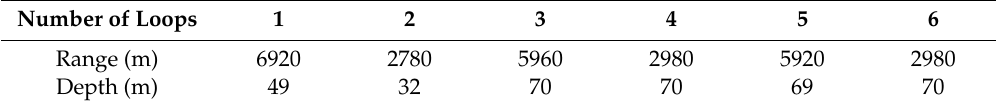
Table 1. The estimated positions using the RAMP method with a spatial filter in each loop.